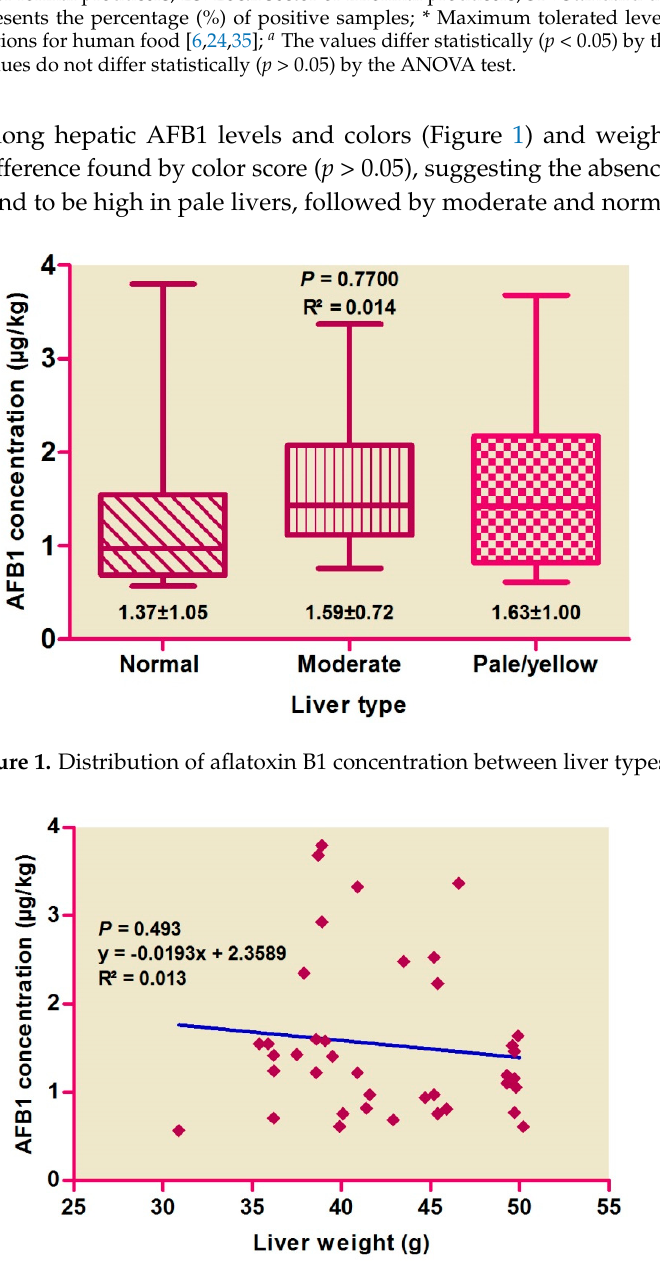
Figure 2. Relationship between aflatoxin B1 concentration in liver samples and the liver weights.